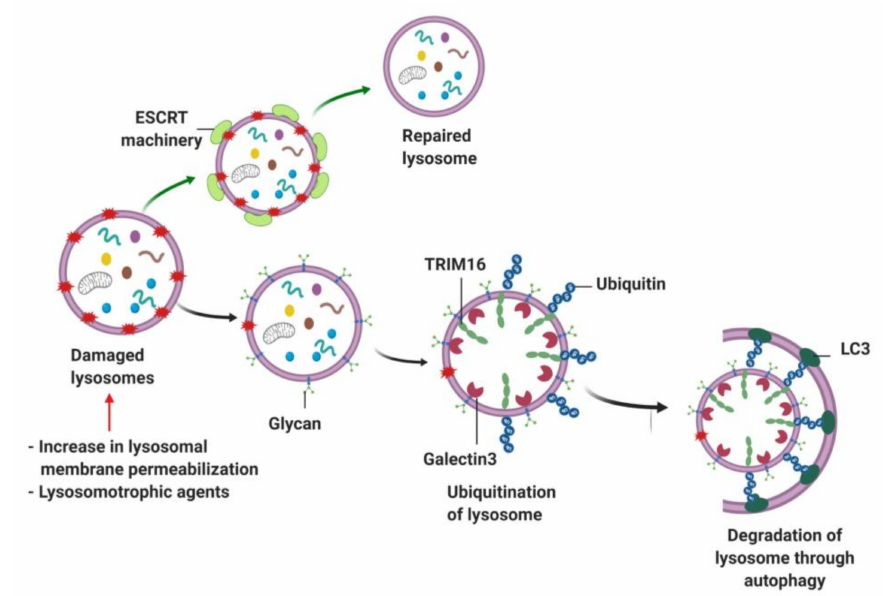
Figure 7. Lysosome repair by lysophagy. Damaged lysosomes can e ffl ux luminal Ca 2 + stores